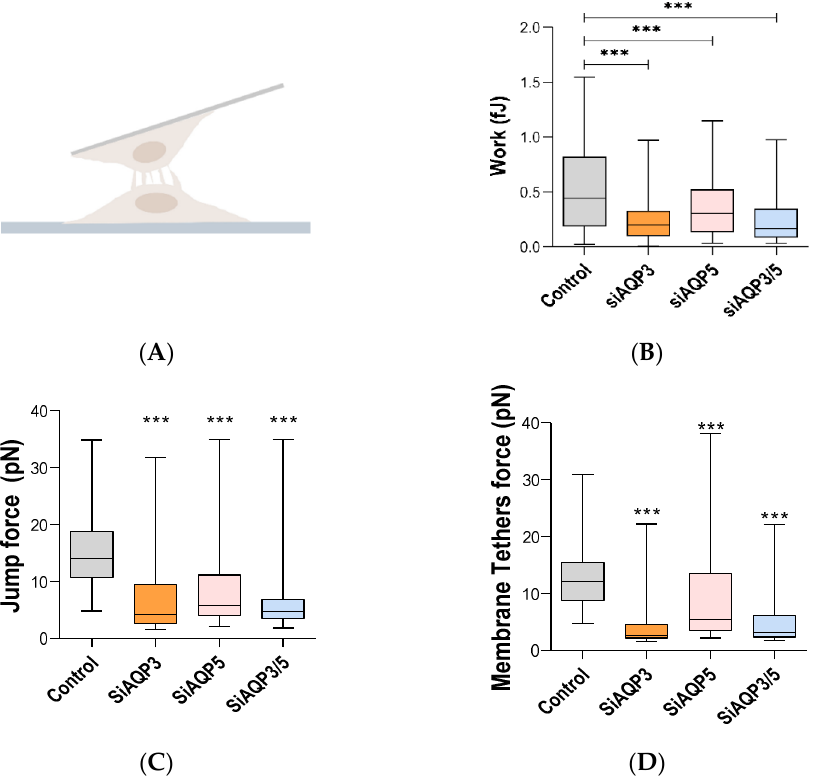
Figure 6. AFM cell–cell adhesion data. ( A ) Schematic representation of the interaction between a cell deposited on the surface of the solid substrate and another cell attached to a tipless AFM cantilever. ( B ) Work (energy) necessary to overcome cell–cell adhesion, detaching one cell from the other. ( C ) Jumps and ( D ) membrane tethers force data. Results were obtained in three independent experiments, with at least 60 force curves analyzed in each of them. *** p < 0.001, silenced vs. control cells.